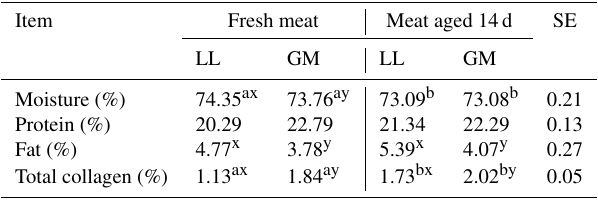
Table 3. The mean values for meat chemical composition for dif- ferent muscles and aging